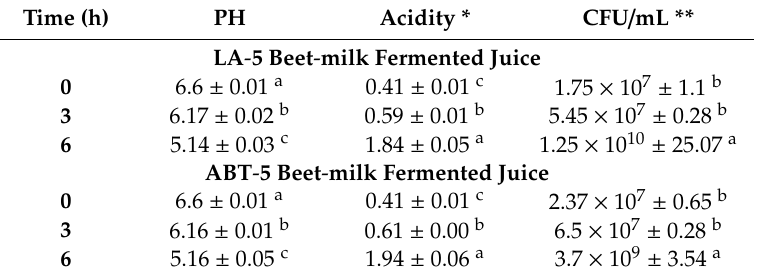
Table 3. PH, acidity, and viable cell count of LA-5 and ABT-5 beet-milk